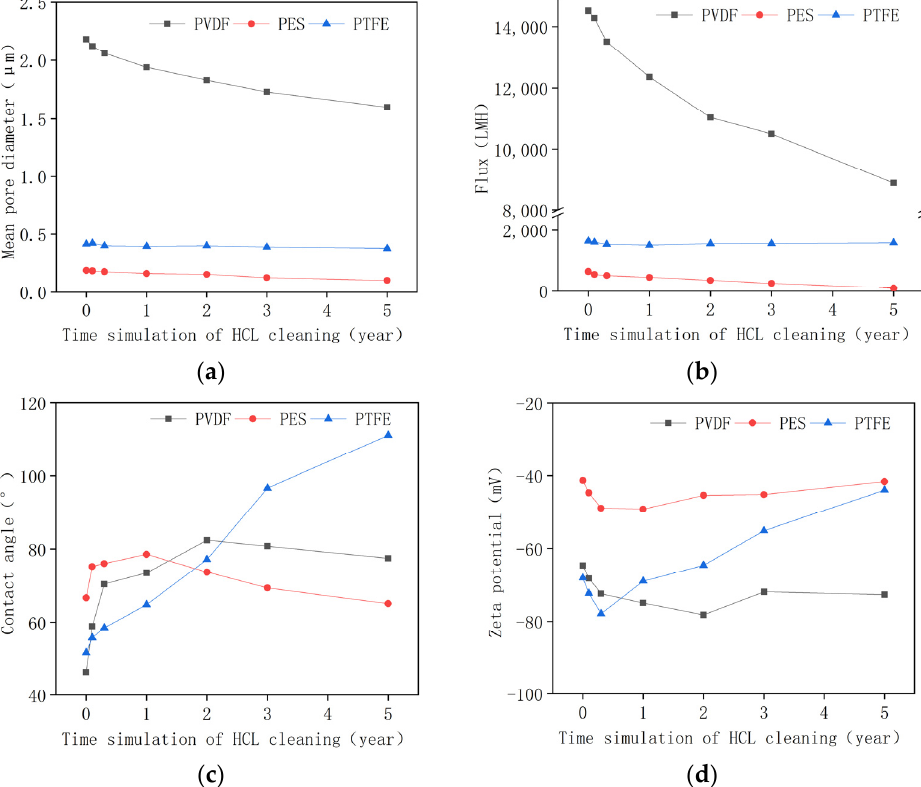
Figure 2. ( a ) Pore size, ( b ) pure water flux, ( c ) contact angle, and ( d ) zeta potential of the pristine membrane and aged membrane in the acid aging test.